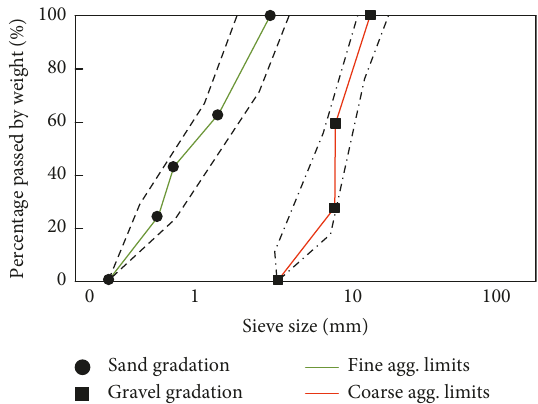
Figure 4: Grade curves of fine and coarse